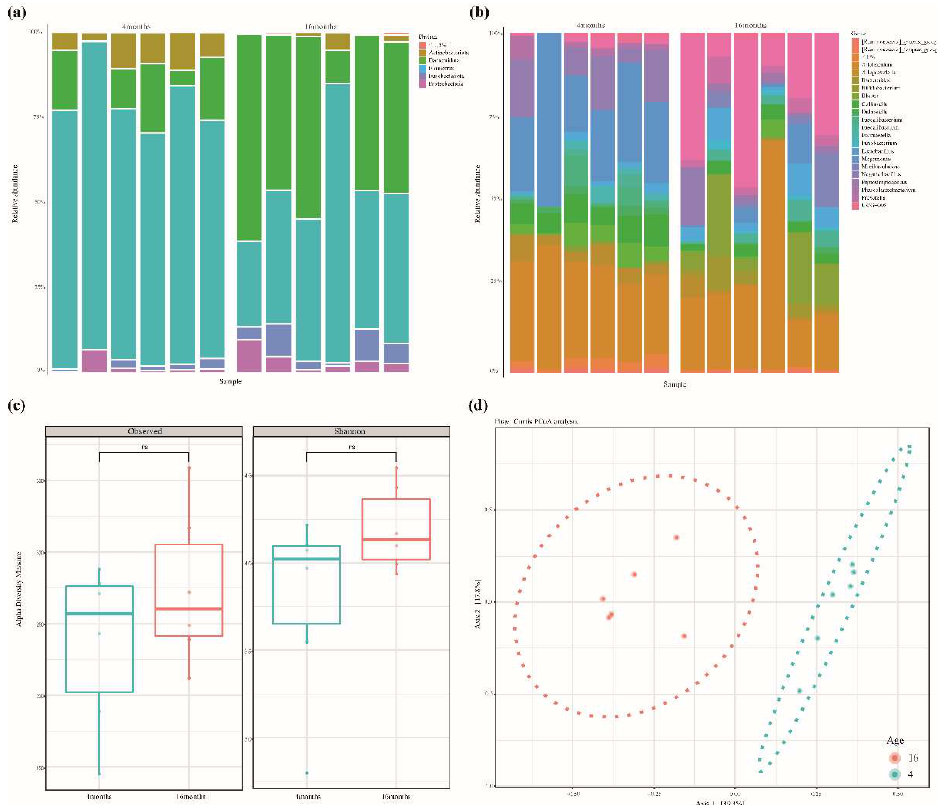
Figure 1. ( a , b ) Relative abundance of fecal microbiota at the phylum and genus level. ( c ) The alpha diversity of the fecal microbiome between the 4-month-old and 16-month-old groups. The richness of fecal microbiota was analyzed by the observed amplicon sequence variants (ASVs). Evenness was evaluated by the Shannon index. There were no significant differences in observed ASVs or Shannon value between growth stages (Kruskal–Wallis, observed-ASVs p-value = 0.42 and Shannon = 0.2). ( d ) Principal Coordination Analysis (PCoA) based on Bray–Curtis dissimilarity distance matrix. Beta diversity in the 4-month-olds (blue) and 16-month-olds (red) is grouped by bacterial compositional